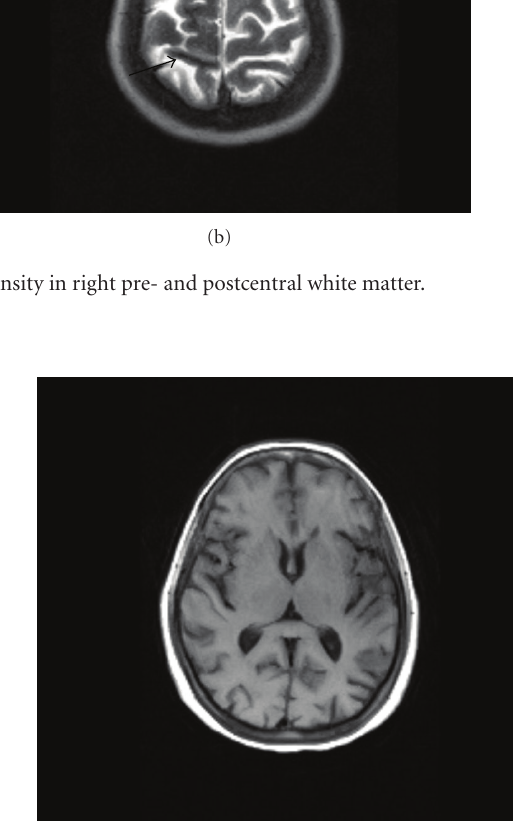
Figure 4: Axial T1 image shows normal basal